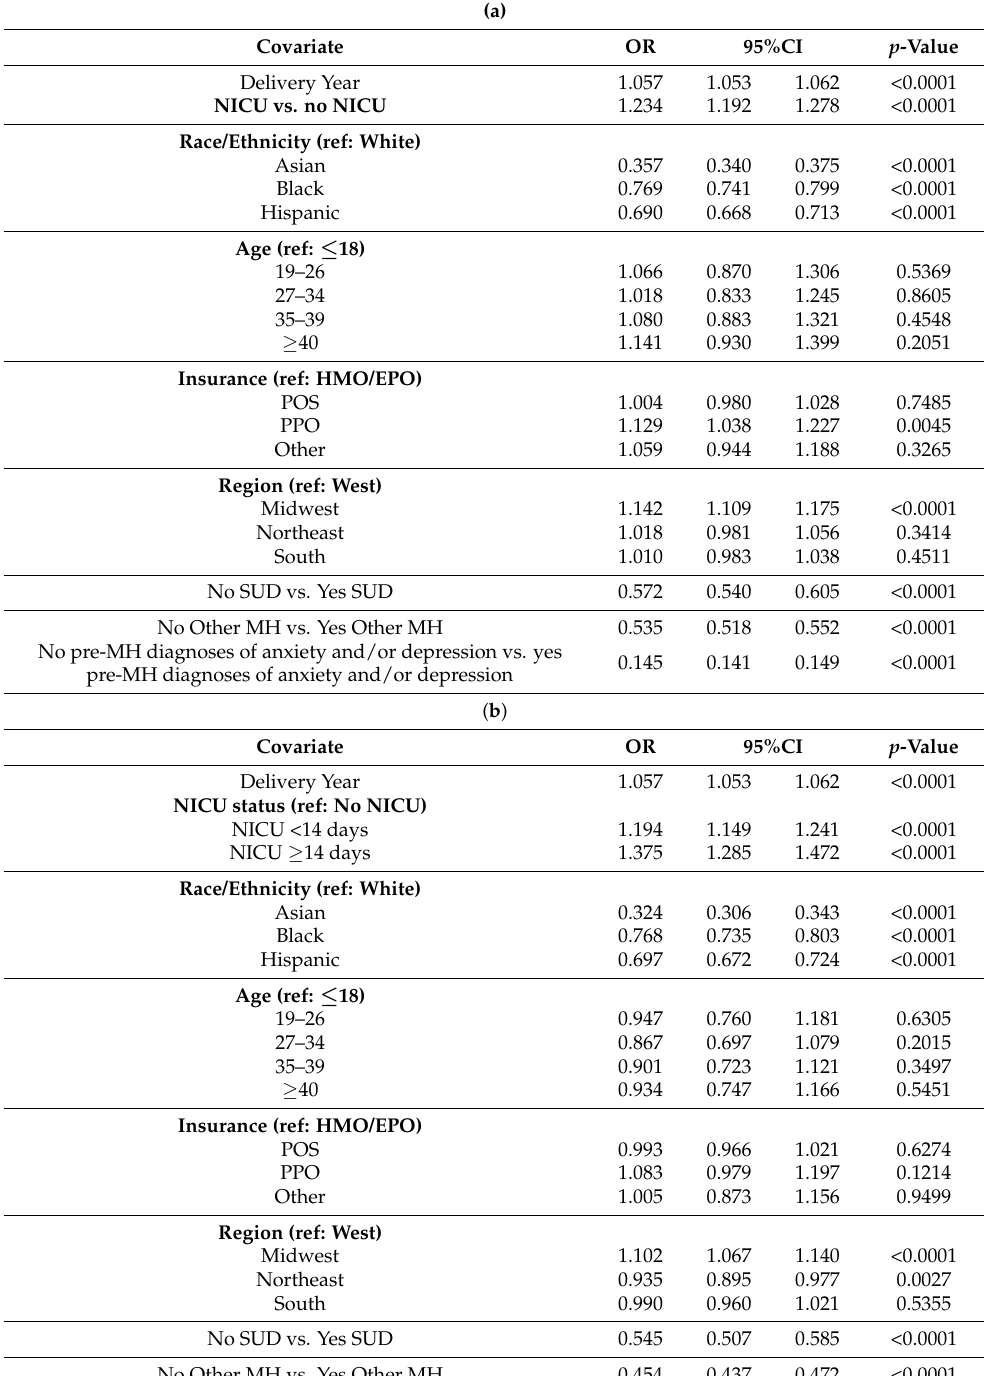
Table 2. ( a ) Adjusted odds ratio and confidence intervals for predicting postpartum MH diagnoses of anxiety and/or depression. NICU categories include no NICU and yes NICU. ( b ) Adjusted odds ratio and confidence intervals for predicting postpartum MH diagnoses of anxiety and/or depression among women with no prenatal MH diagnosis. NICU categories include no NICU, <14 days, and ≥ 14